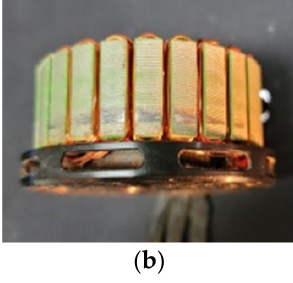
Figure 3. ( a ) Normal motor; ( b ) Motor with a damaged rotor.